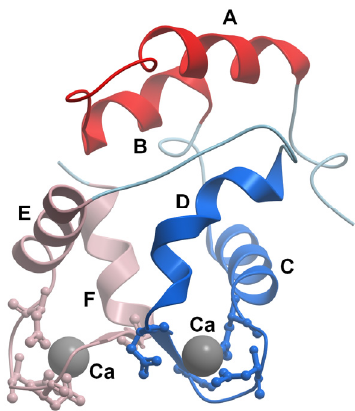
Figure 1. Ribbon model of the 3D-structure of rat parvalbumin (oncomodulin) (PDB code 1rro) with two bound calcium ions. Three EF-hand domains are shown by different colors. Helices are marked with letters from A to F. Ca 2+ coordinating Asp and Glu residues are shown.